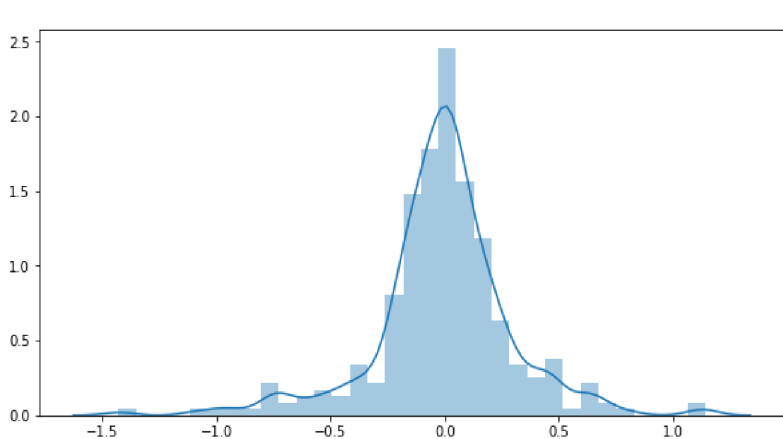
Figure 9. Optimised-DNNR prediction.